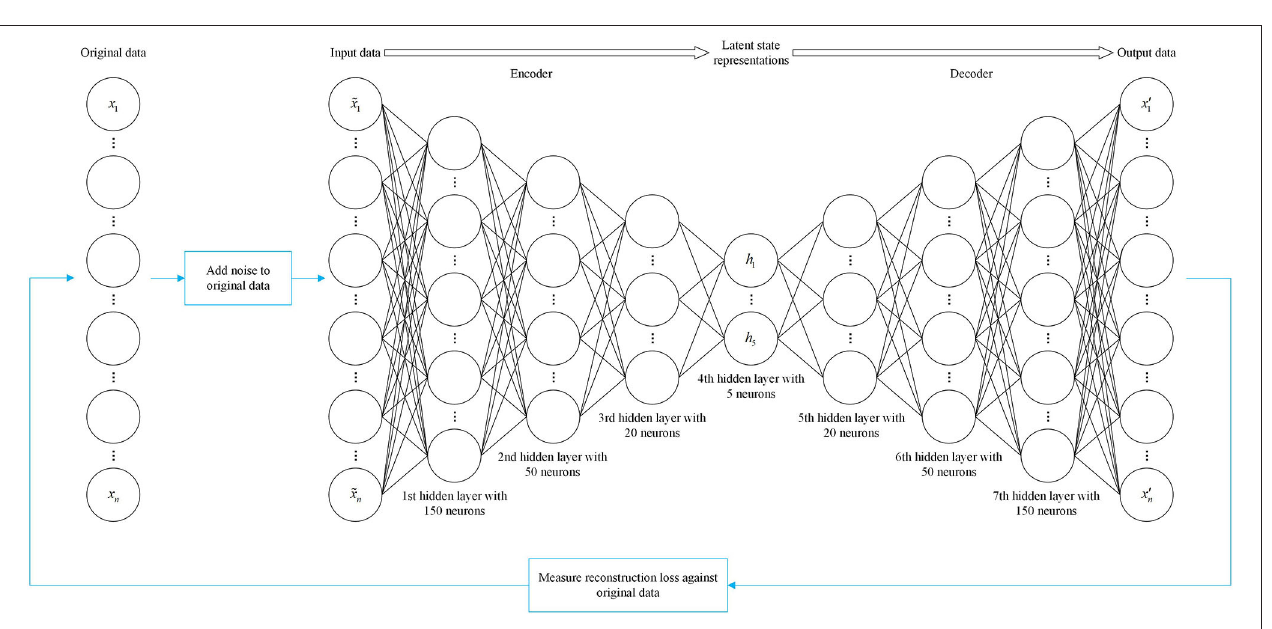
FIGURE 5 | Architecture of the denoising